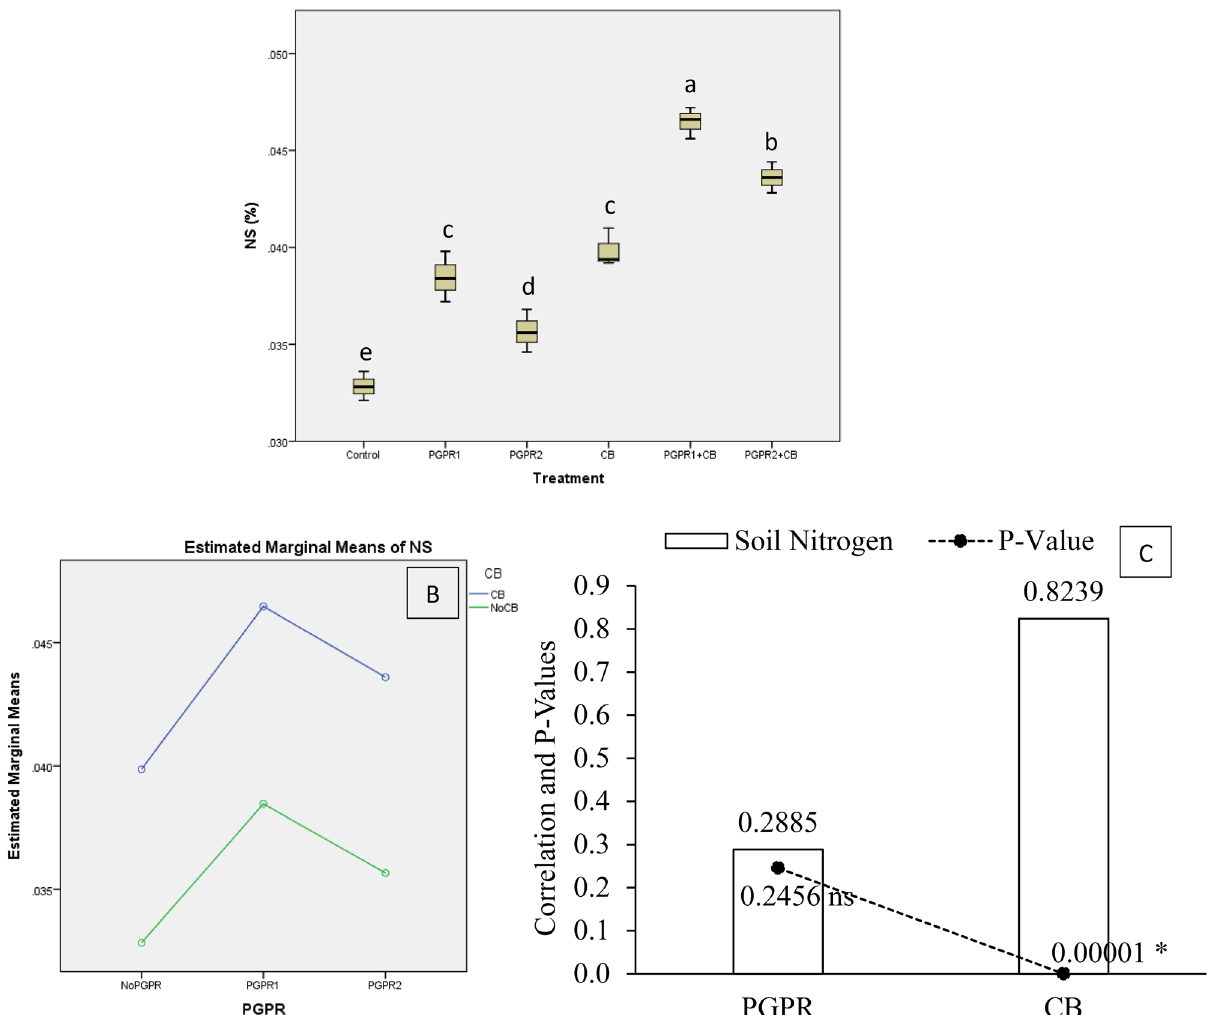
Figure 4. Effect of treatments on soil nitrogen (NS). Values are the average of three replicates ( A ). Different letters showed significant differences (Tukey’s test; p ≤ 0.05). Interaction graph of PGPR and CB for soil NS ( B ). Correlation graph of PGPR and CB for soil NS ( C